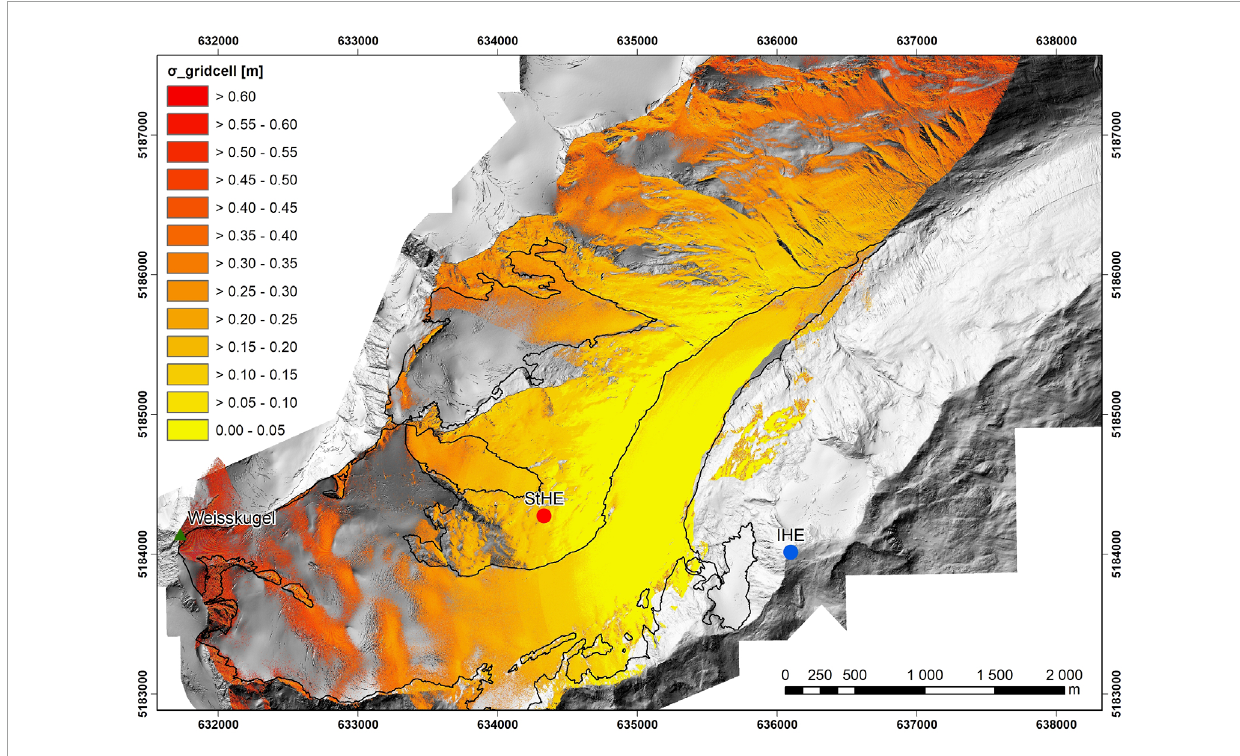
FIGURE 11 Distributed TLS uncertainty with the point density taken into account ( σ gridcell ) .